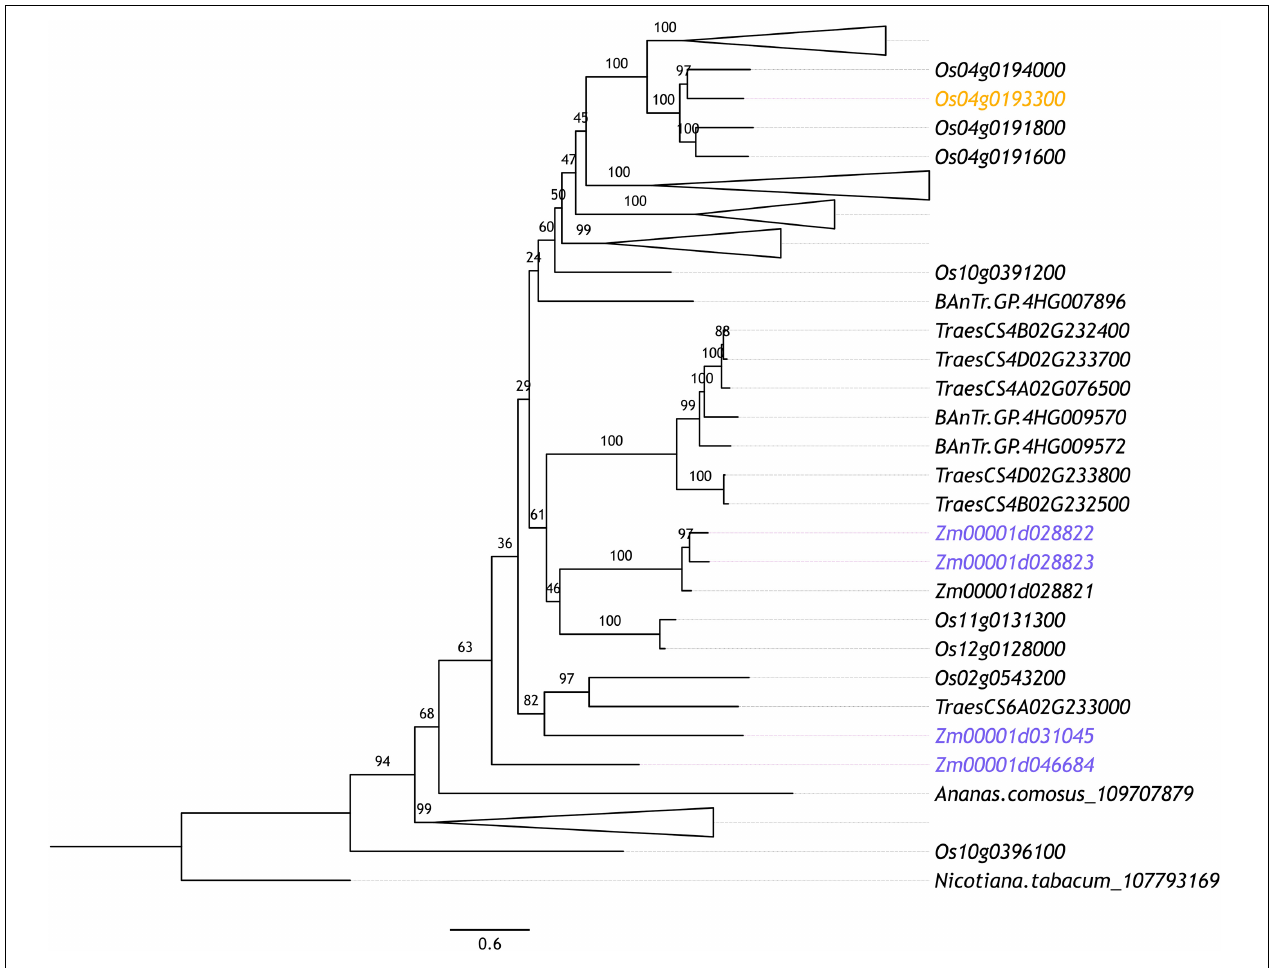
FIGURE 3 | Maximum likelihood phylogenetic tree of orthologous maize and rice F-box genes whose expression is indicated to be up-regulated in PMCs according to Yuan et al. (2018) (highlighted in blue) and Tang et al. (2010) (highlighted in orange), respectively. Orthologous sequences were identified from tobacco ( Nicotiana tabacum ), rice ( Oryza sativa ), maize ( Zea mays ), pineapple ( Ananas comosus ), and Barley ( Hordeum vulgare ) Anther and Meiocyte Transcriptome (BAnTr) dataset using OrthoFinder (v.2.3.3; Emms and Kelly, 2015). The longest orthologous sequences from each species were aligned using MAFFT (v7.266; Katoh and Standley, 2013). Alignments were refined using Gblocks (v0.91b; Castresana, 2000). Maximum likelihood phylogeny was computed using IQ-TREE (v1.6.9; Nguyen et al., 2014) with ultrafast bootstrapping ( n = 1,000). The resultant phylogeny was plotted using FigTree (v1.4.3). Branches are labeled with bootstrap